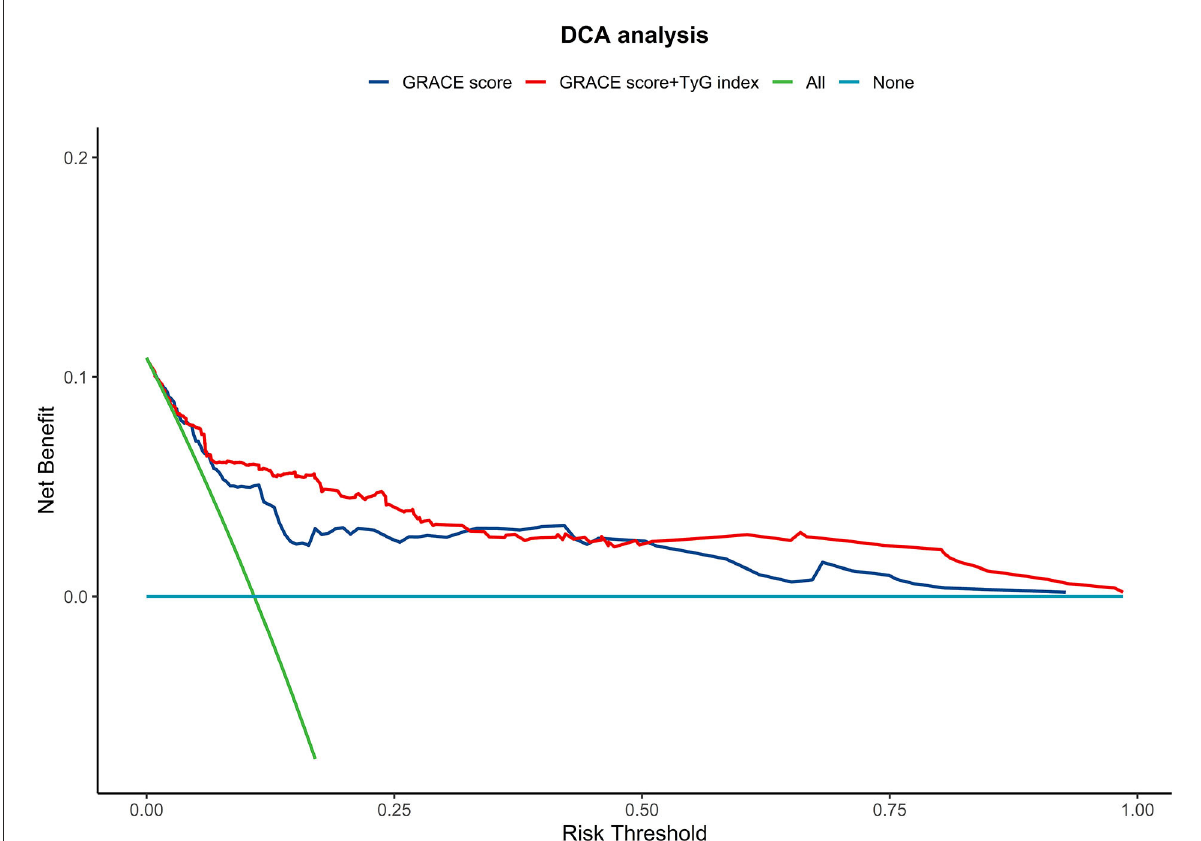
FIGURE3 The decision curve analysis (DCA) comparing the GRACE risk score and its combination with the TyG index. GRACE score, Global Registry of Acute Coronary Events score; TyG index, triglyceride-glucose